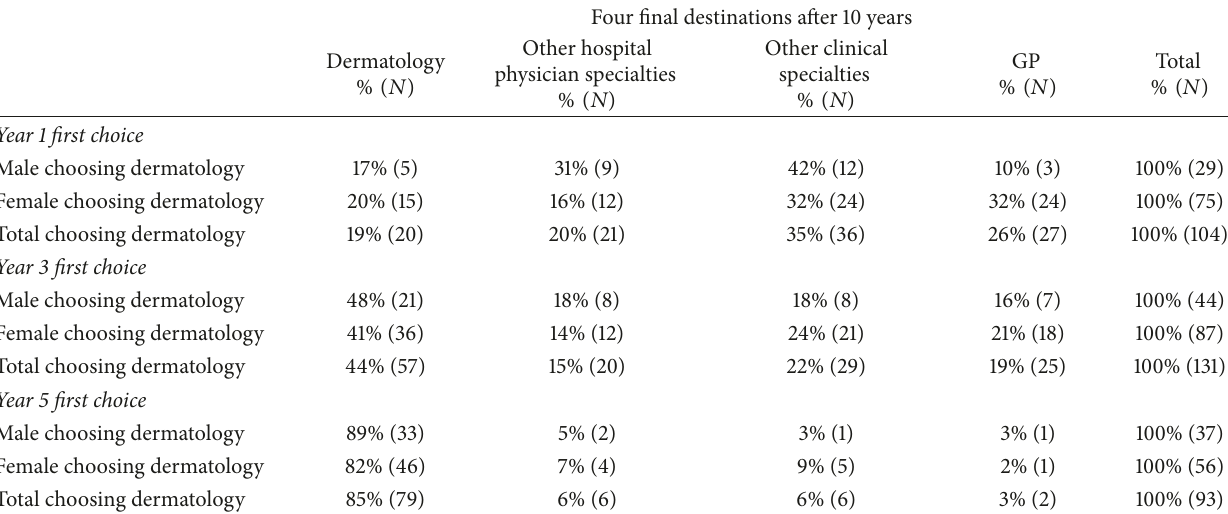
Table 5: Numbers and percentages of medical graduates whose original choice was dermatology and eventually practised at four different destinations in year 10 (looking